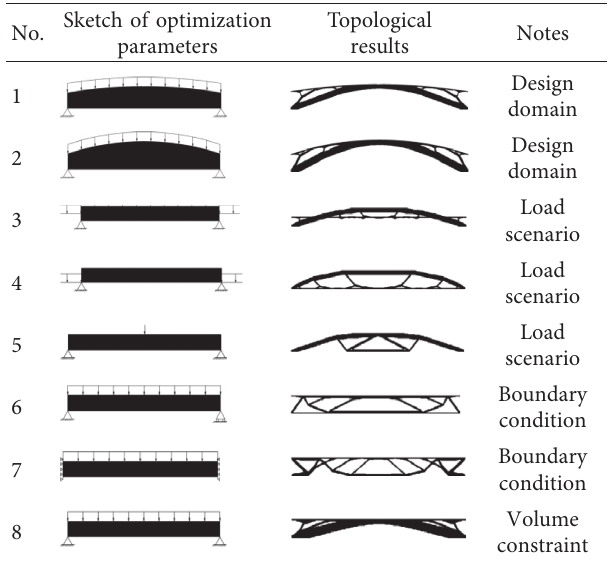
Table 10: Topological result of extended examples of beam/arch.